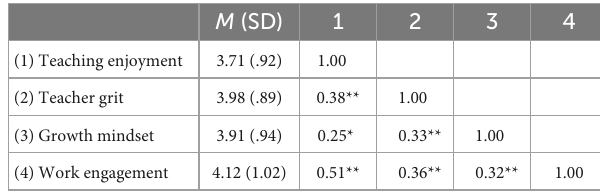
TABLE 4 Descriptive statistics and